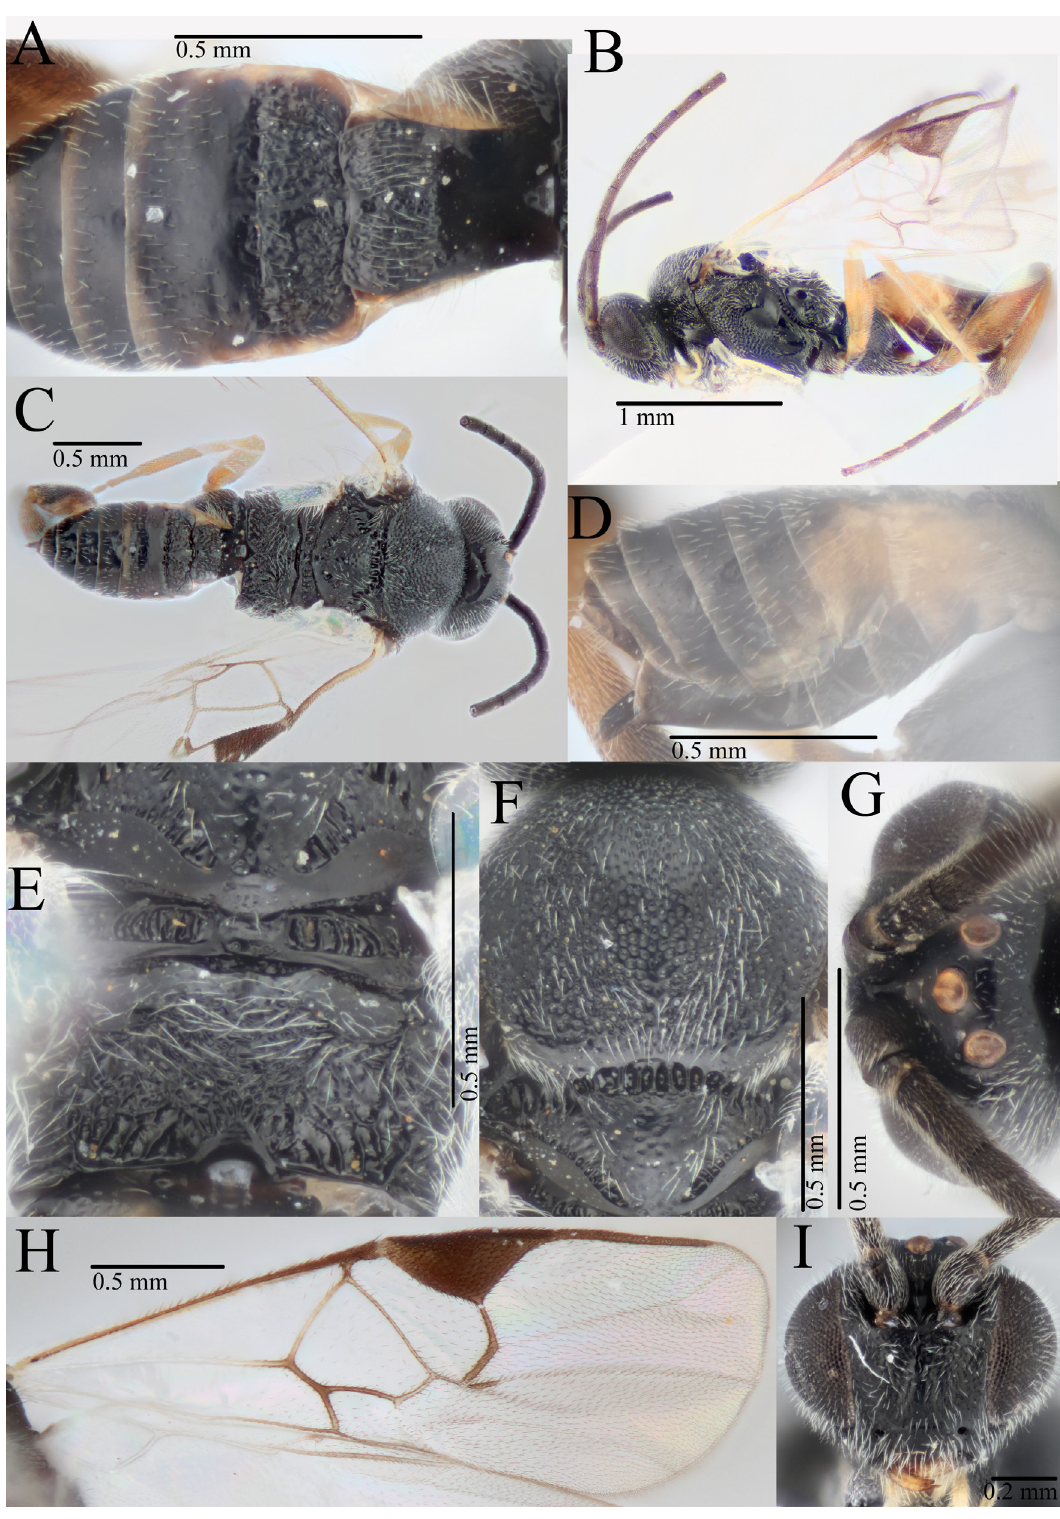
Fig. 30. Cotesia tjapekki sp. nov., holotype, ♀ (SAMA 32-035867) A . Metasoma in dorsal view. B . Habitus in lateral view. C . Habitus in dorsal view. D . Metasoma in lateral view. E . Mesoscutellum and propodeum. F . Anteromesoscutellum and scutellar disk. G . Head in dorsal view. H . Fore wing. I . Head in anterior